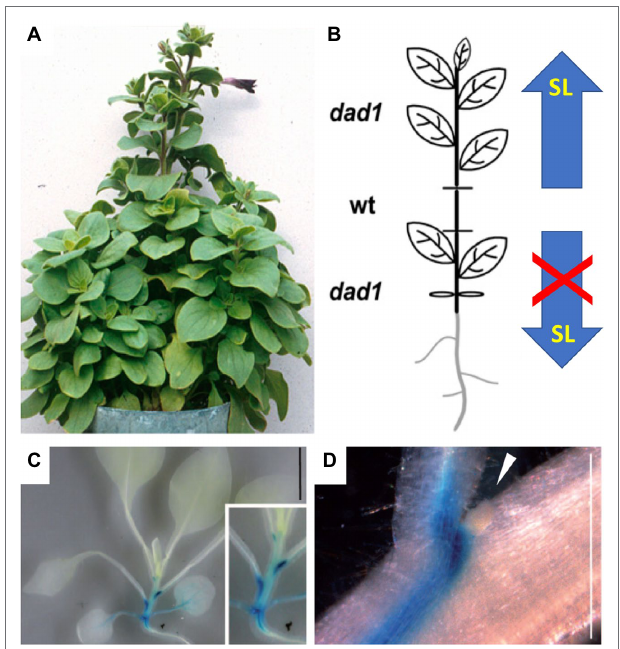
FIGURE 2 | SL transport in the plant. (A,B) Grafting experiments have proven acropetal SL transport in the shoot. A small wild-type stem segment (wt) complements the dad1 phenotype in the scion (top), while the dad1 stock exhibits the non-complemented high branching phenotype (bottom); thus, only upward SL transport occurred. The scheme in (B) represents the organization of the grafted plant in (A) . (C,D) Expression pattern of the cellular SL transporter pPhPDR1::GUS in the shoot of P. hybrida . Note highest expression just below the axillary buds, while the buds themselves [arrowhead in (D) ] show no expression [modified with permission from Simons et al., 2007 (A,B) and Kretzschmar et al., 2012 (C,D)